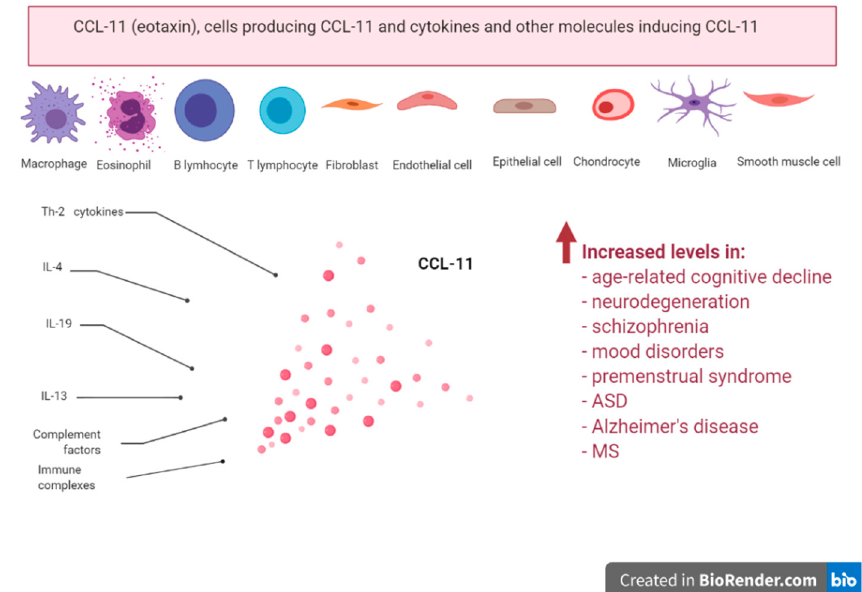
Figure 1. Take-home message; producers and inducers of CCL-11; increased levels in age-related cognitive decline, neurodegeneration, schizophrenia, mood disorders, premenstrual syndrome, ASD, Alzheimer’s disease and multiple sclerosis (MS).